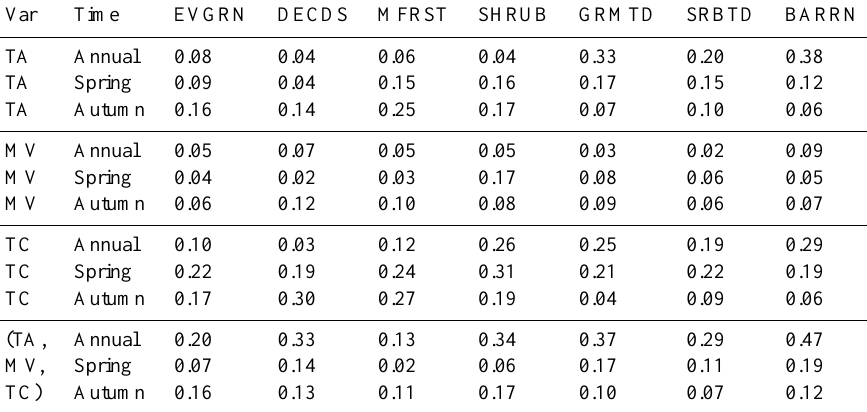
Table B1. R 2 values of ACE transformed SWE and ACE transformed air temperature (TA), volumetric soil moisture (MV) and vegetation canopy transmissivity (TC). Linkages are indicated using observations collected over three non-overlapping time periods of the snow and growing seasons. Associations are therefore indicated between mean annual values of SWE and growing-season values, and between mean SWE 30 days prior to snowmelt and growing-season values 30 days following full snowmelt (Spring), and vice versa (Autumn). In the multivariate case, the p values of all coefficients are statistically significant. All p values corresponding to the pair-wise ACE transformations are < 10 − 5